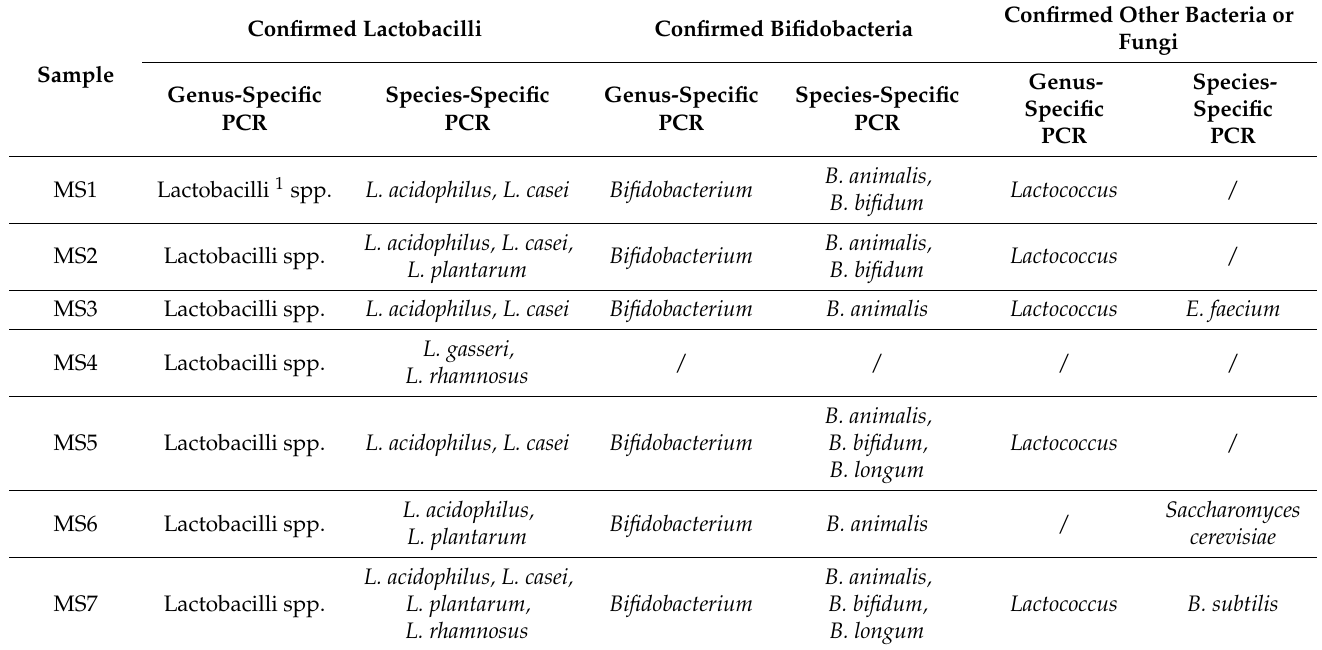
Table 6. Presence of conducted genera-specific and species-specific PCR products of multi-strain probiotics.